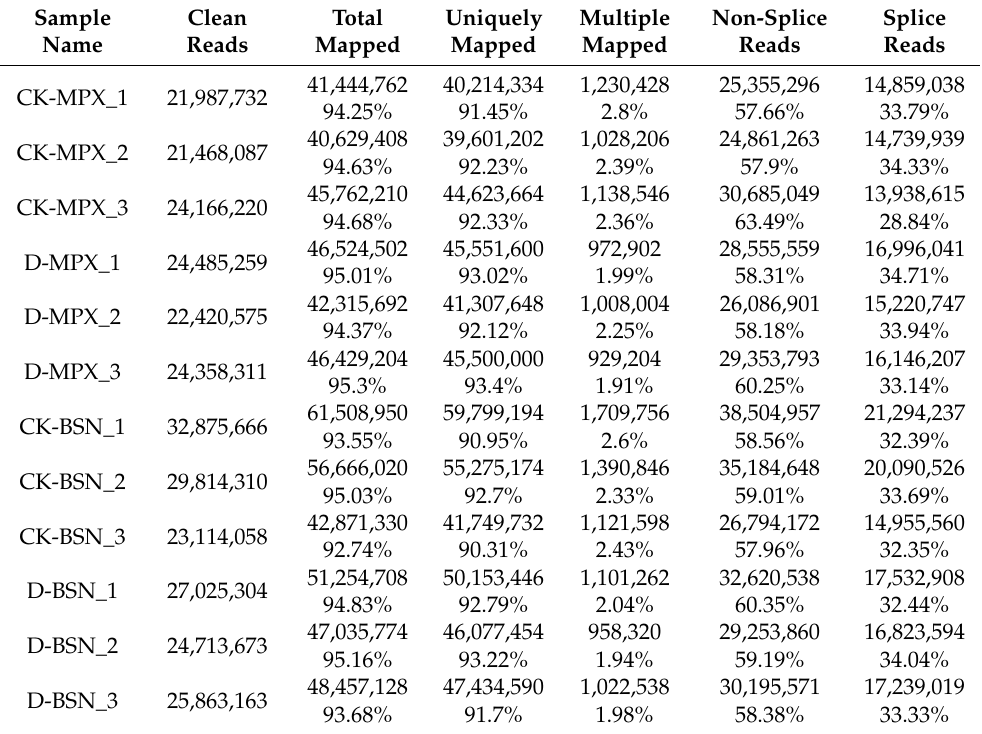
Table 2. Shanlan upland rice clean reads compared with Nipponbare series.